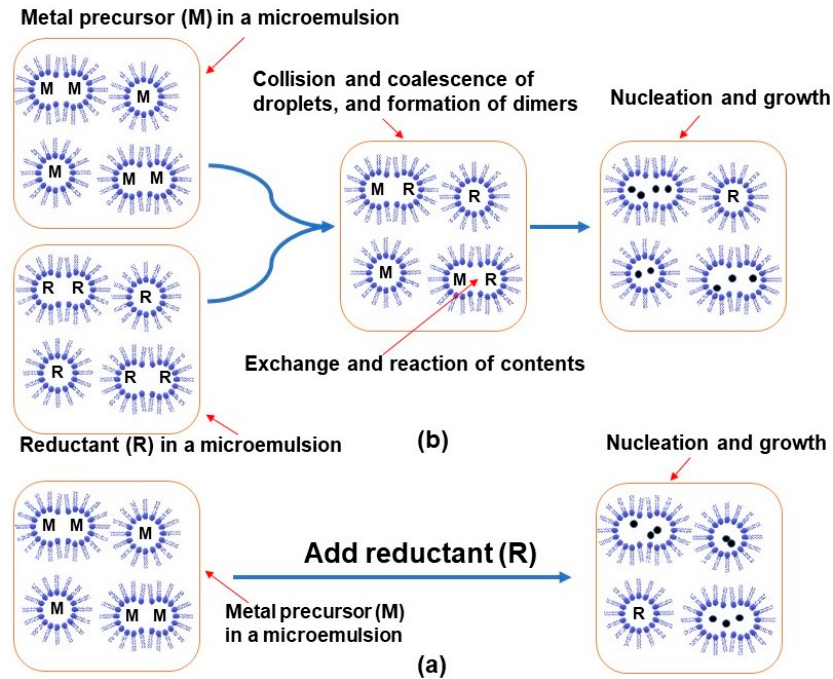
Figure 3. Colloidal synthesis by a microemulsion technique: ( a ) adding directly the reducing agent to the microemulsion containing the dissolved metal precursor; ( b ) mixing two microemulsions containing metal precursor and reductant.